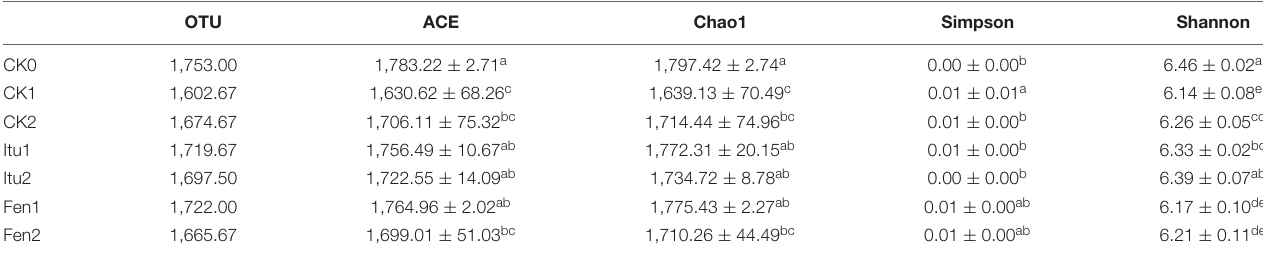
TABLE 3 | OTU abundance and diversity index of bacterial communities in all soil samples.